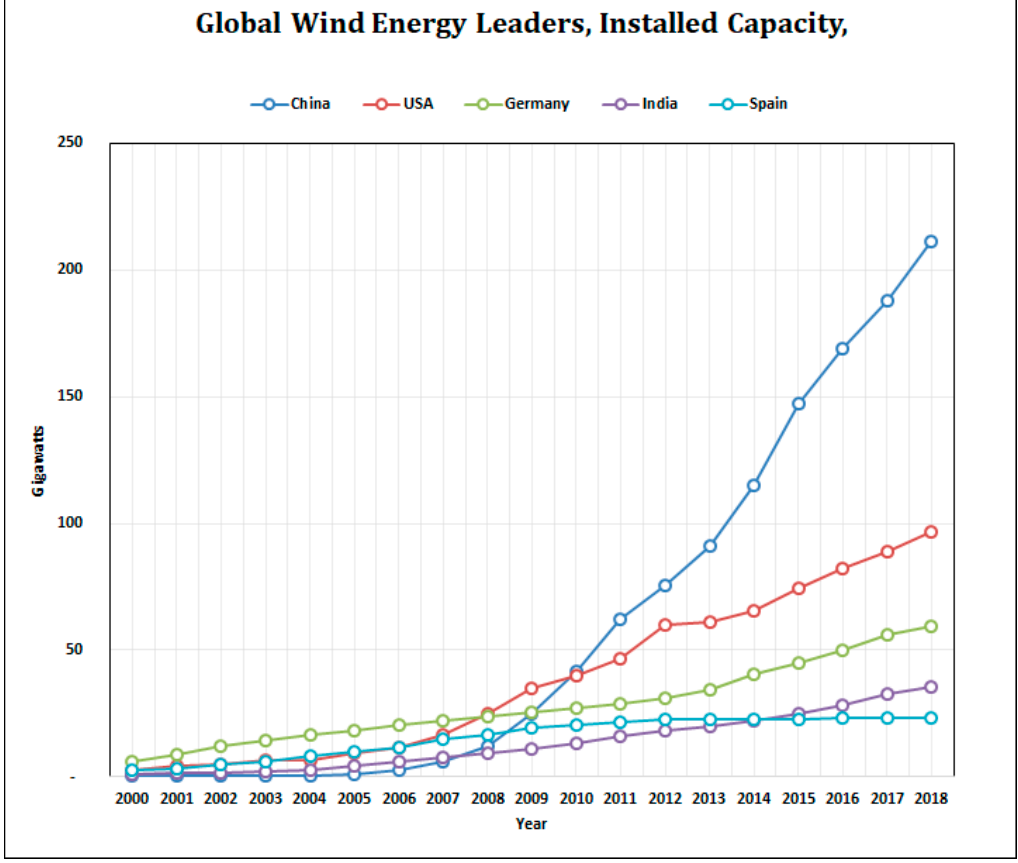
Figure 2. Country level wind energy capacity growth. Data source: The Wind Power, Statistics [19].